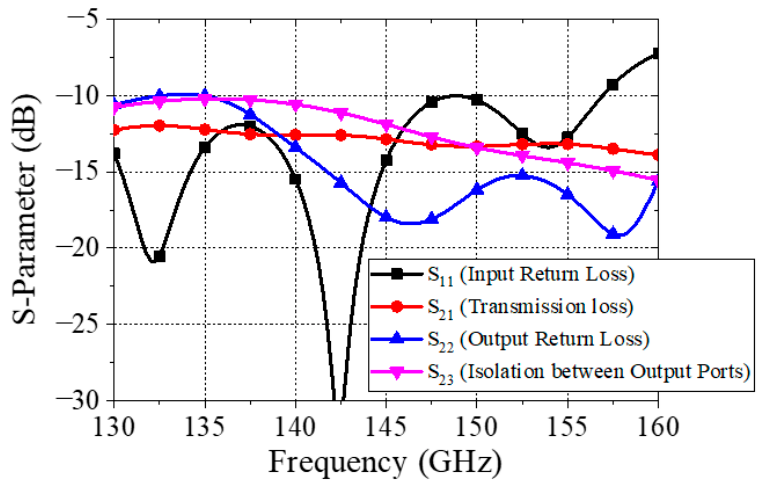
Figure 7. S-parameter performance of the developed one-by-eight Wilkinson power divider.